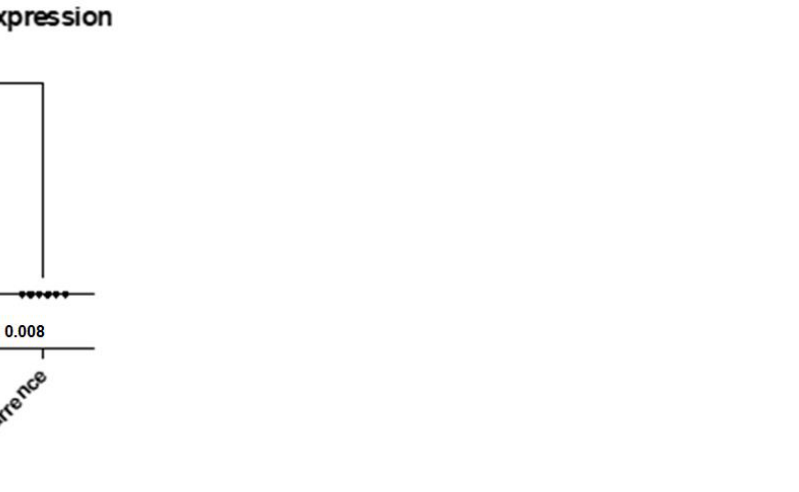
Figure 4. Bar graph displaying the CPS score as a percentage for all patients grouped by their recurrence status. As all tumor samples of patients with relapse in course of treatment were PD-L1-negative there is a statistically significant difference between those two groups ( p = 0.008, Mann – Whitney test).